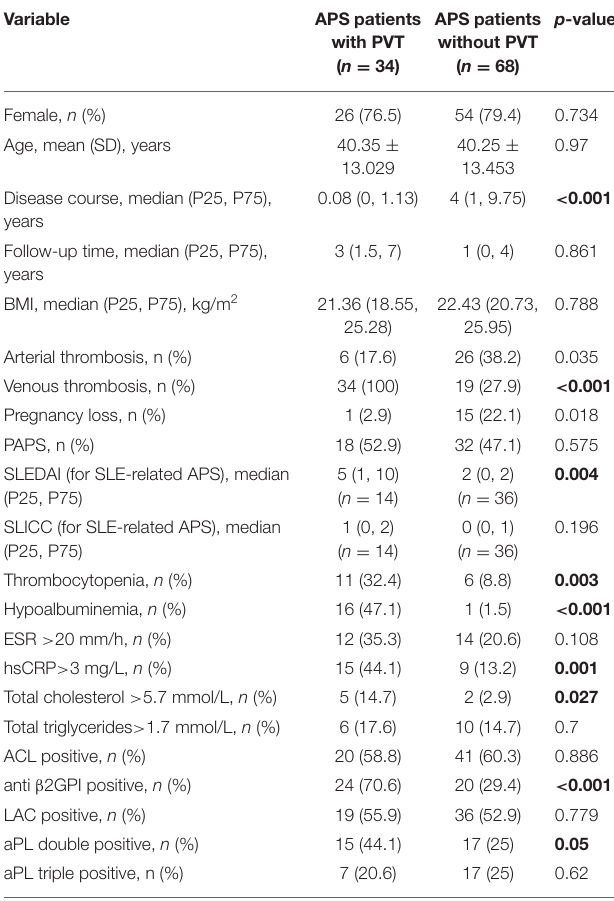
TABLE 1 | Comparison of demographic characteristics, clinical and laboratory manifestations between APS patients with and without PVT.